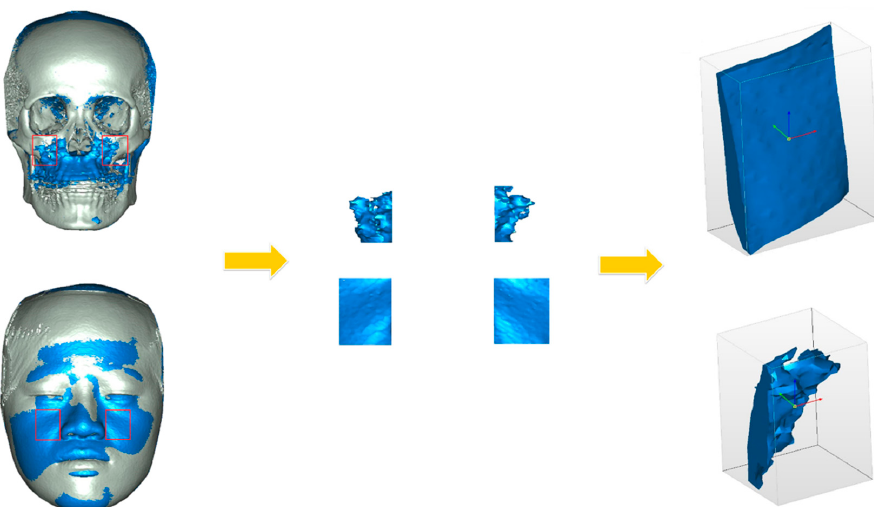
Figure 5. Workflow from registration to calculation of 3D bone and soft tissue volumetric change in the anteromedial cheek region, bilaterally. ( Left ) Superimposed preoperative and postoperative 3D facial bone and soft tissue models. ( Center ) The computer-generated 3D overall volumetric changes (mm 3 ) were processed as postoperative minus preoperative 3D models. ( Right ) 3D bone and soft tissue models representing the overall volumetric change were exported to Magics 13.0 software for further calculation.